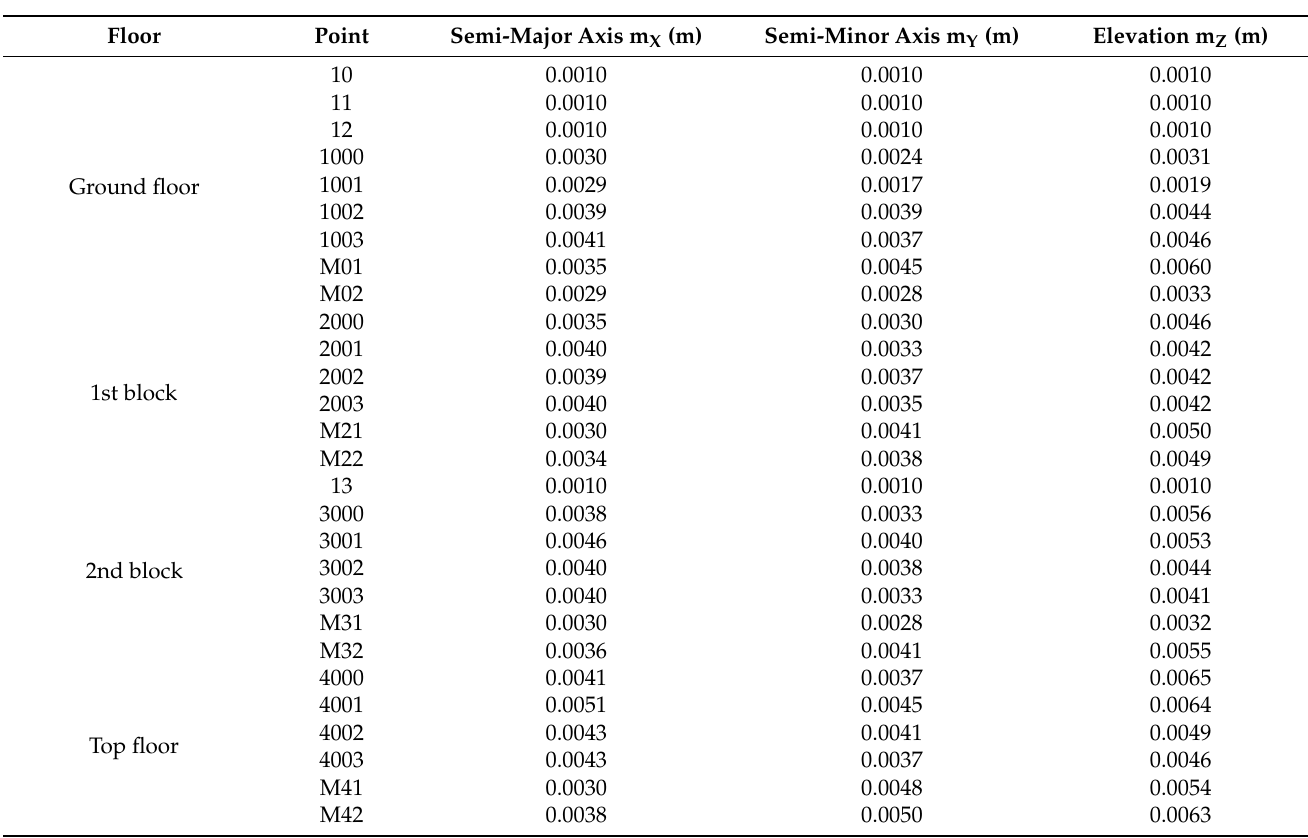
Table A1. The accuracy of the point coordinate